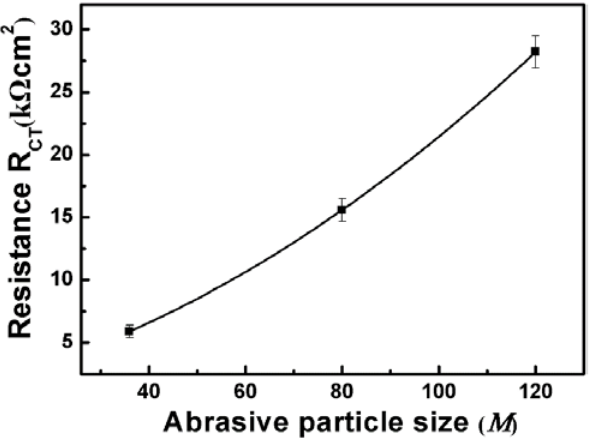
Figure 4. R CT of the equivalent circuit evaluated by fitting the impedance spectra of the ground surface with different abrasive particle sizes.